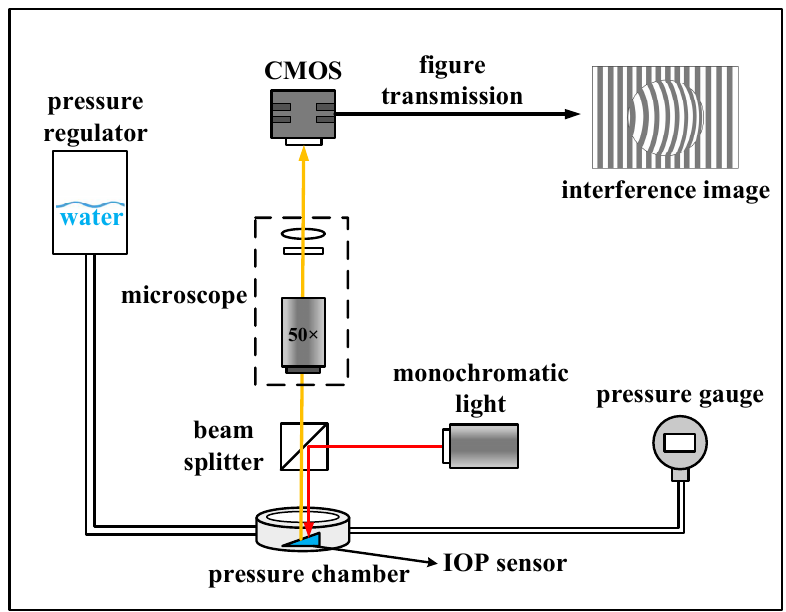
Figure 5. The setup of the experiments of sensor performance testing.